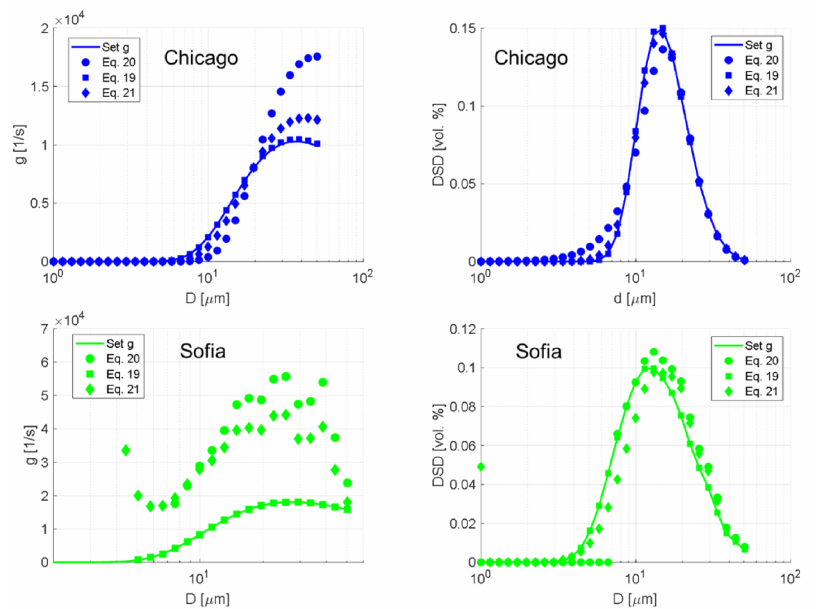
Figure 7. Sensitivity of the different methods to the choice of f . Left column compares set fragmenta- tion rates obtained by equal size fragments, Equation (19) (solid lines) to estimations using a range of assumed f shapes (circles: Equation (20), squares: Equation (19), and diamonds: Equation (21)). The right column compares the validation data DSD after 20 passages (solid lines), to the DSD predicted based on the different f -assumptions. Showing the Sofia method (top row) and the Chicago method (lower